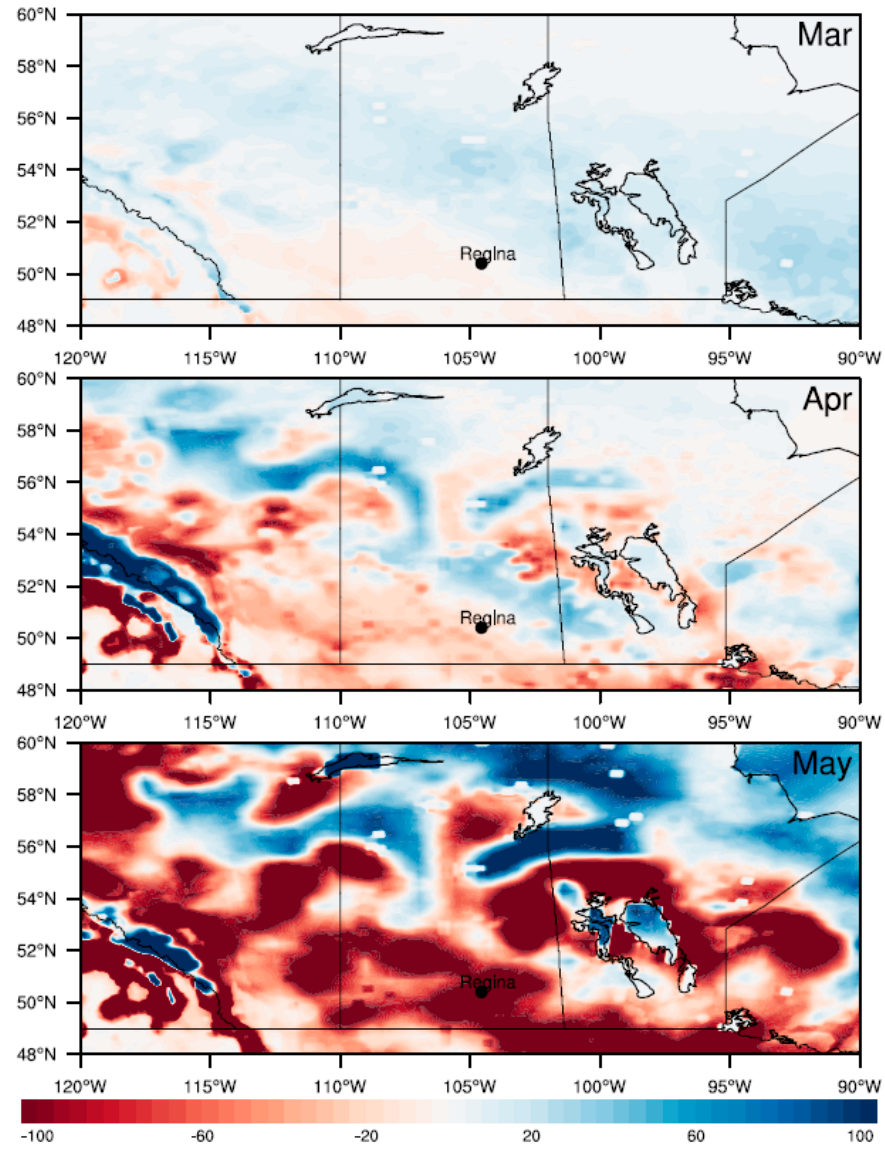
Figure 9. WRF simulated difference (ELX-LAX) in spring runoff (mm). Table 2. Differences in recorded flow (m 3 /s) of the North and South Saskatchewan Rivers (NSR and SSR) in Alberta (AB) and Saskatchewan (SK) between 2011 and 2016.